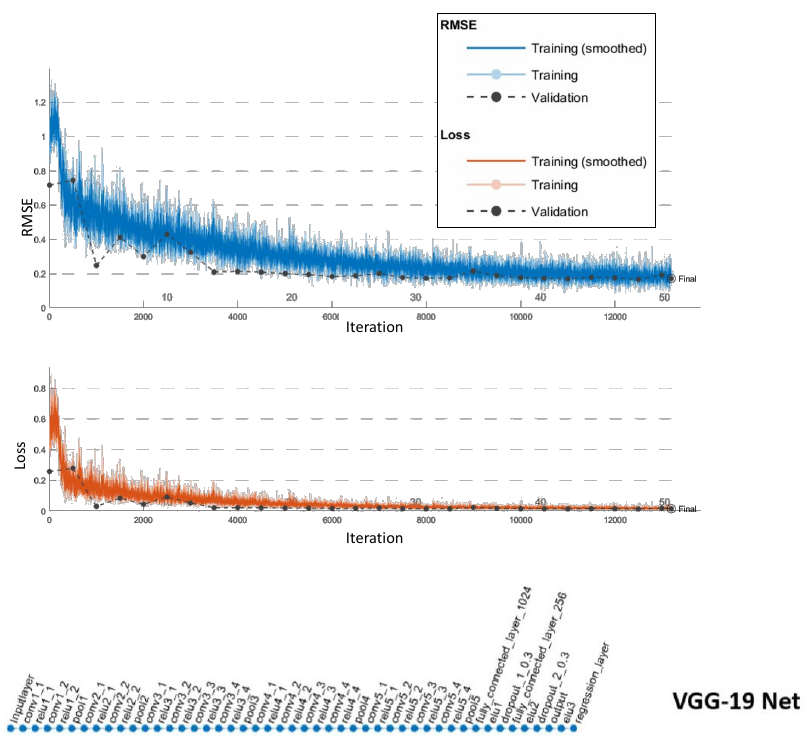
Figure 9. VGG-19: configured with a learning rate of 10 − 1 , piece-wise scheduling, and 50 Epochs. Trained in 989 min and a final validation RMSE of 0.17.